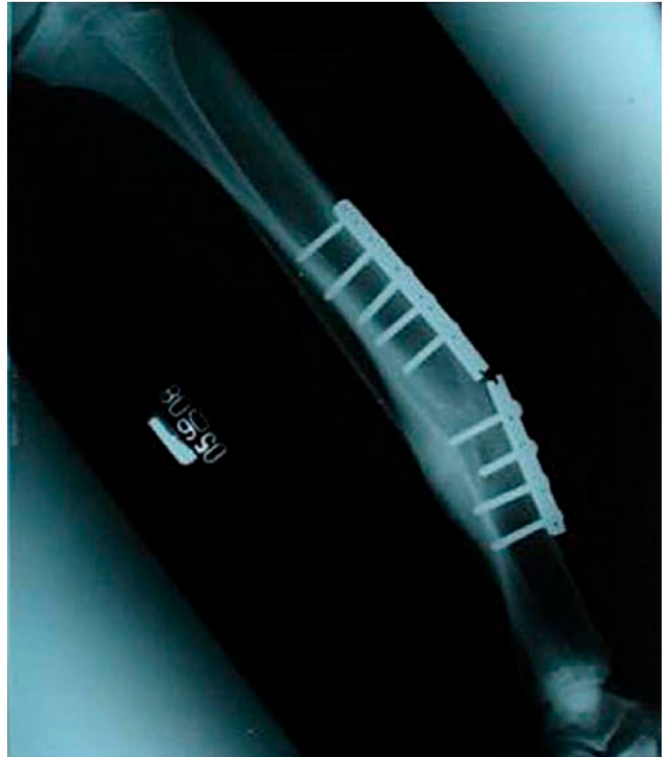
Figure 2. Radiographic image of a failed stainless steel implant due to fatigue